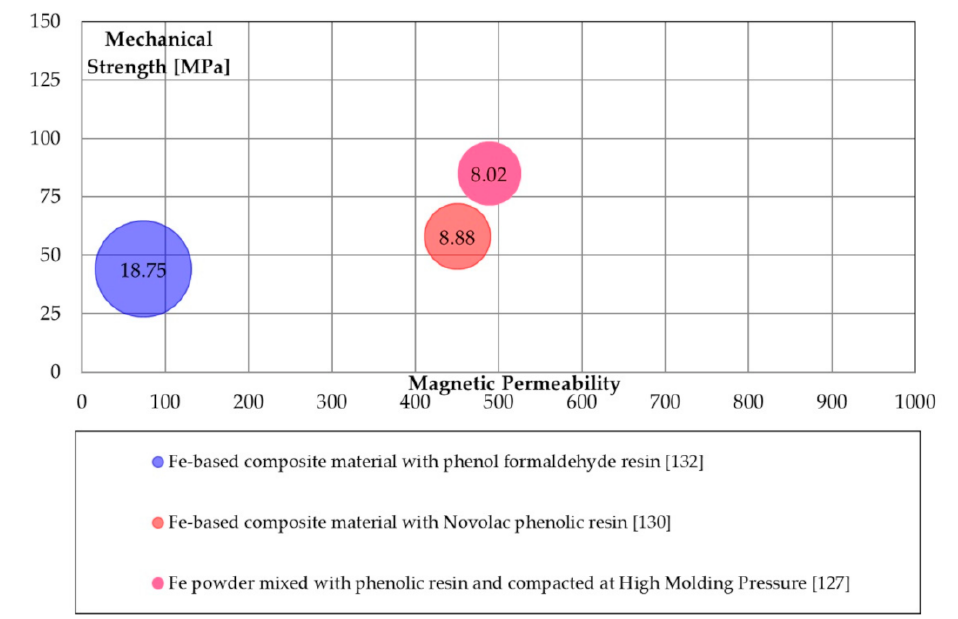
Figure 8. Magnetic (maximum permeability), mechanical (TRS [MPa]), and energetic properties (total iron losses 1 T@50 Hz [W/kg]) of epoxy coating processes.